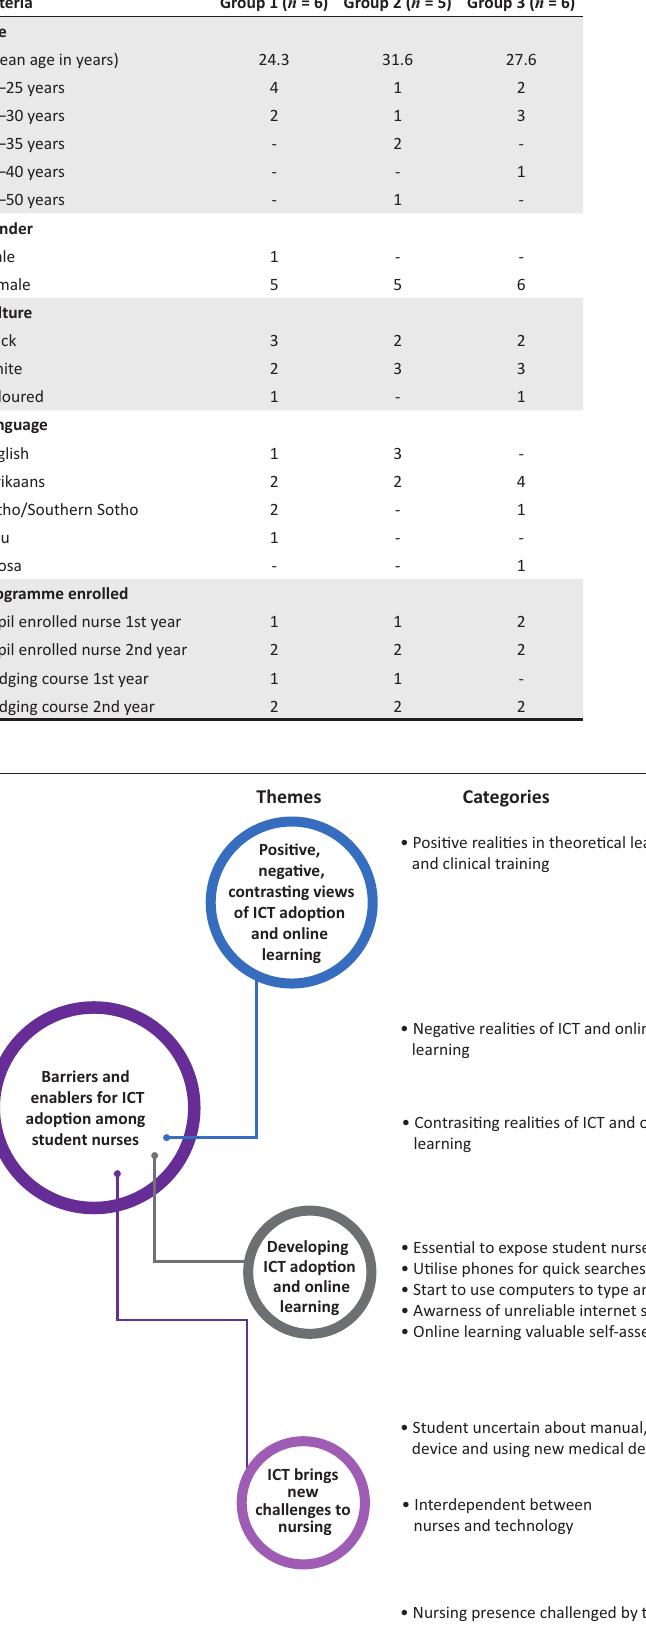
TABLE 1: Demographic data of participants ( N = 17).